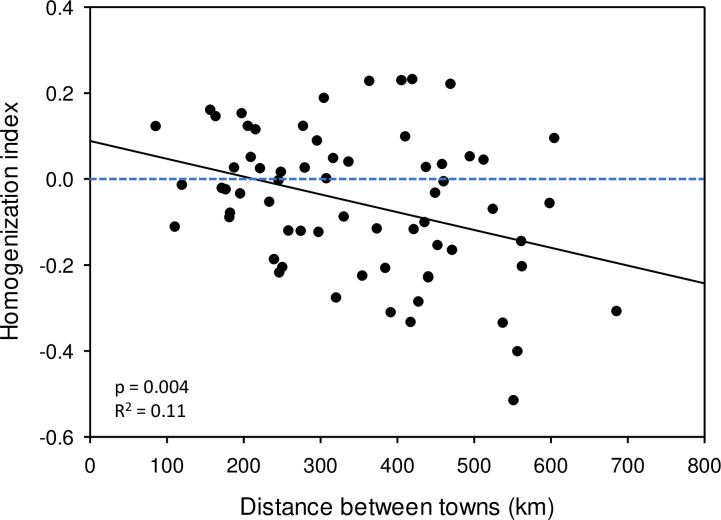
Relationships between the homogenization index and distance between pairs of towns (N = 66).The dashed blue horizontal line is the transition between biotic homogenization (> 0) and biotic differentiation (< 0).